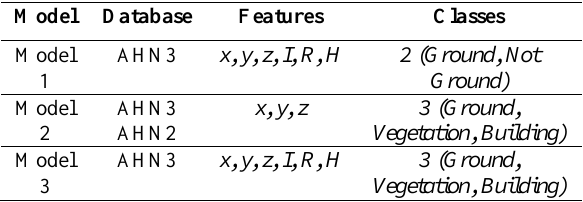
Table 2. Summary of the classification models